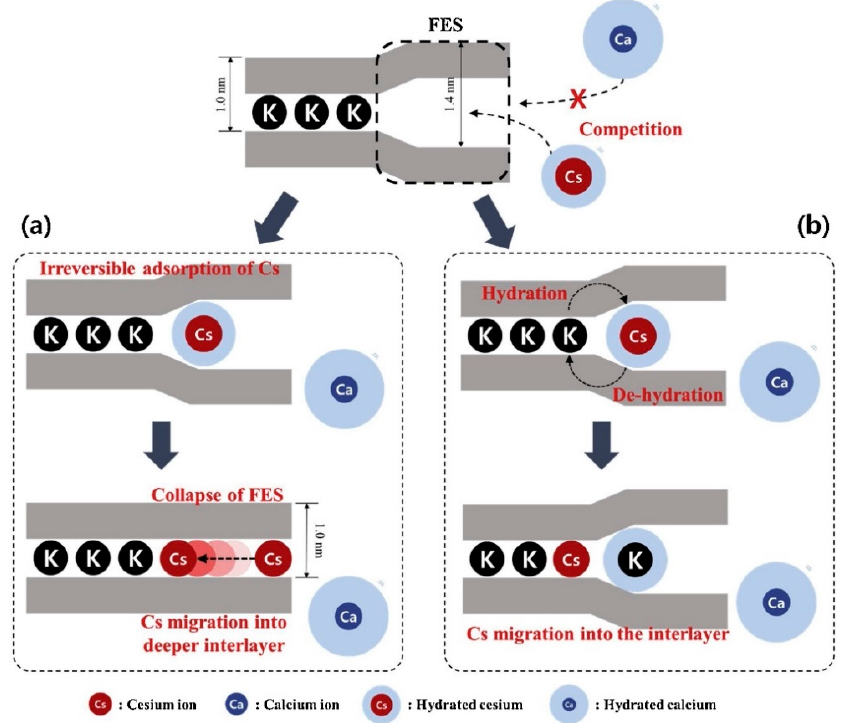
Figure 7. Schematic illustration of the Cs + adsorption sites onto the illite interlayers thanks to: ( a ) the collapse of FES; and ( b ) the dehydration of Cs + . Reprinted with permission from reference [100].